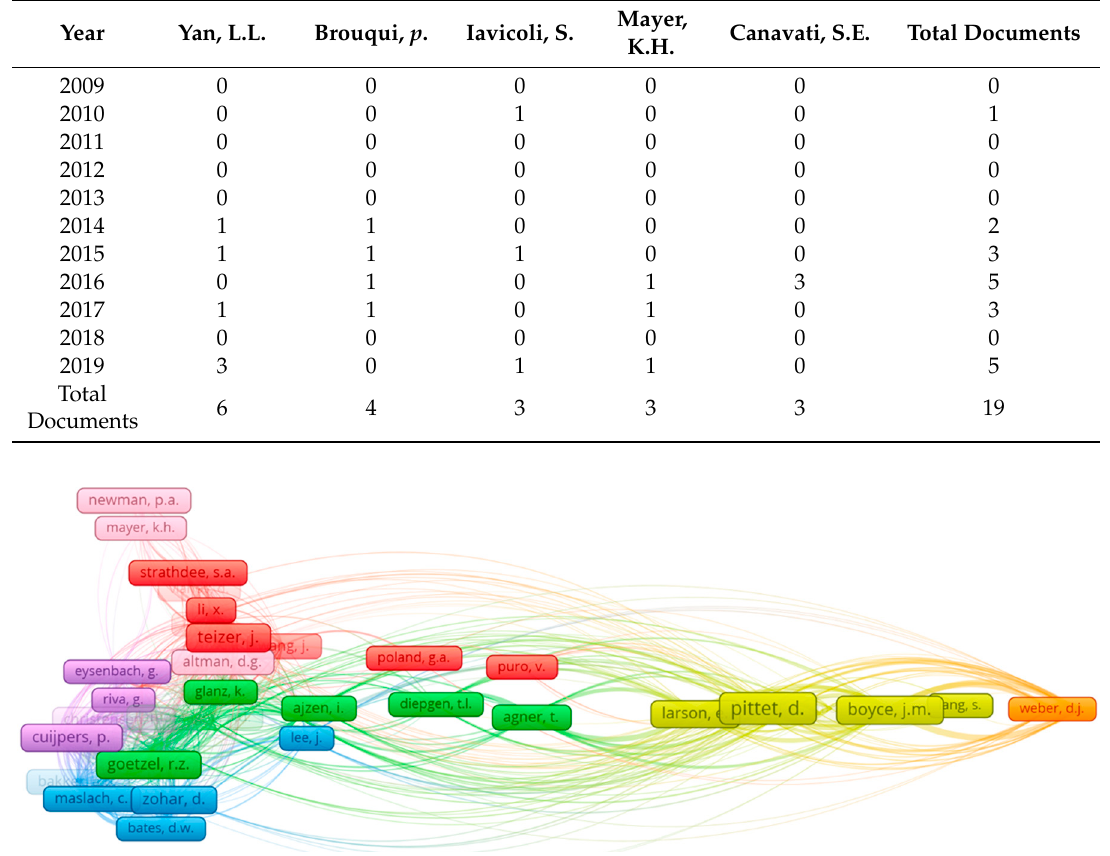
Figure 5. Co-citation between authors.